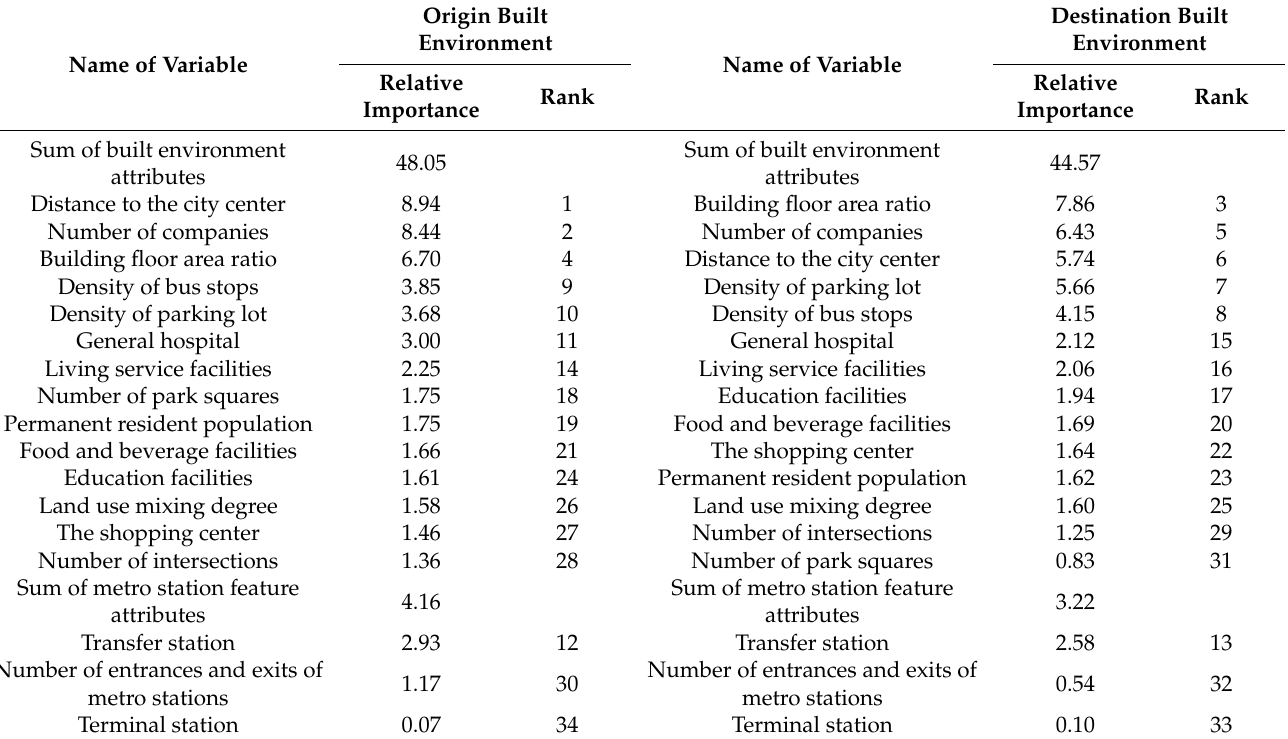
Table 2. The relative importance of built environment factors for metro